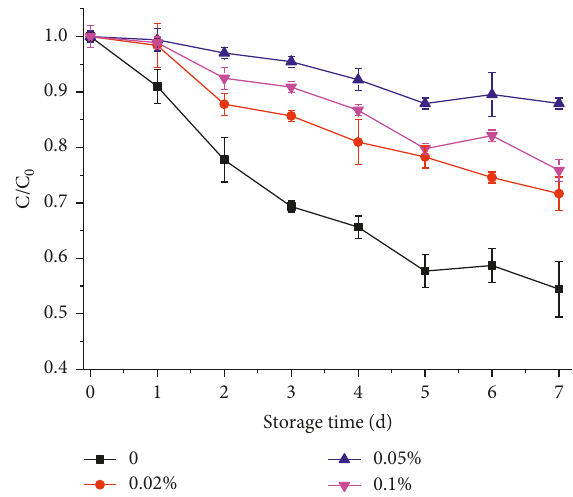
Figure 2: Effect of the different concentrations of rosemary extract (in the oil phase) on the degradation of lutein in WPI-stabilized emulsions during the storage at 55 ° C. Data points represent means ( n � 3) ± standard